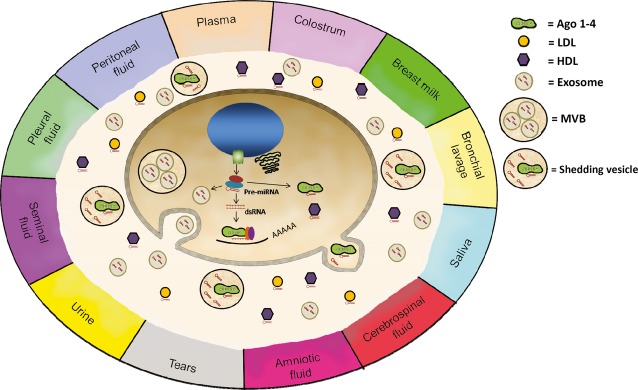
Origin of extracellular RNA. Several hypotheses have been proposed to explain the source of circulating RNA, including the passive release of RNA from broken cells and tissues following tissue injury, chronic inflammation, cell apoptosis or necrosis or from cells with a short half-life. Alternatively, active secretion of cfRNA can occur in association with subcellular components including exosomes, microparticles, microvesicles or extracellular vesicles 19,135–137. Additionally, there is emerging evidence for active secretion by cells as RNA-binding-protein conjugated complexes. Cell-free miRNA have been detected in 12 different body fluids: plasma, saliva, tears, urine, amniotic fluid, colostrum, breast milk, bronchial lavage, cerebrospinal fluid, peritoneal fluid, pleural fluid and seminal fluid 59. Ago 1–4: argonaute proteins 1–4; LDL: low-density lipoprotein; HDL: high-density lipoprotein; MVB: multivesicular body.